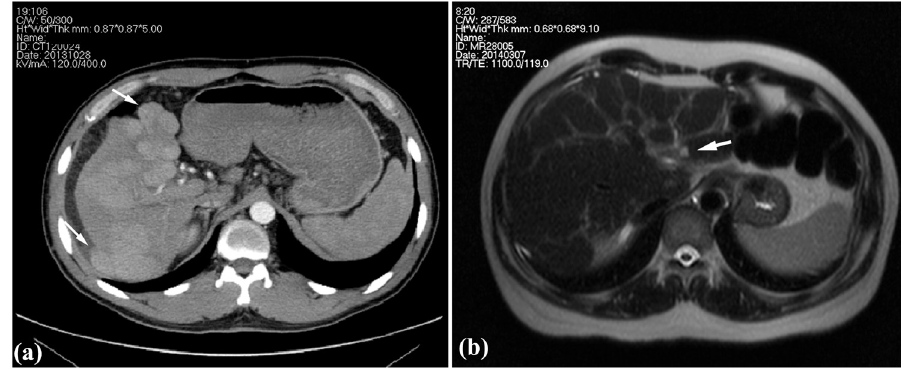
Figure 1: Images of clinical cases. ( a ) Enhancement CT showing the multiple intrahepatic nodules protruded from the liver surface ( arrow ) in Case 1 and ( b ) T2WI of MR showing heterogeneous fi brosis and a nodule in the left inner lobe ( arrow ) in Case